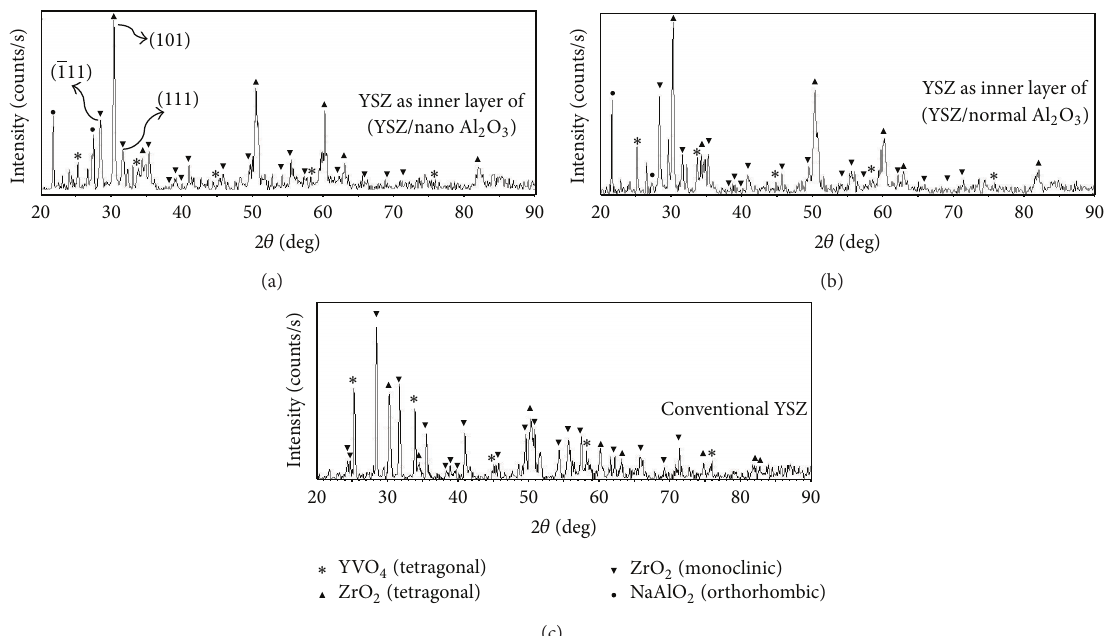
Figure10:XRDpatternsof(a)normalYSZlayer,(b)YSZasinnerlayerofYSZ/normalAl 2 O 3 coating,and(c)YSZasinnerlayerofYSZ/nano- Al 2 O 3 coating after hot corrosion testing.